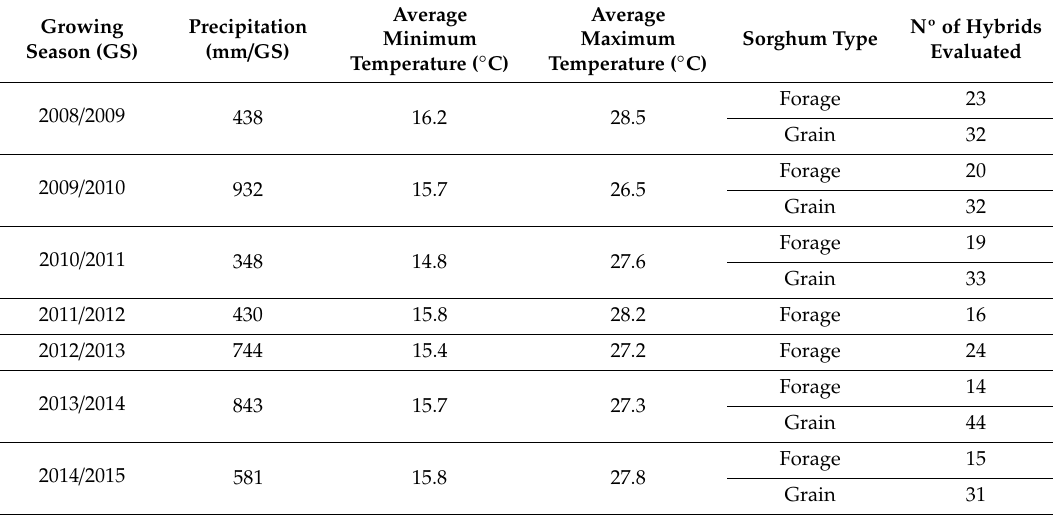
Table 1. Climate description and number of forage and grain sorghum hybrids evaluated in each growing season (spring and